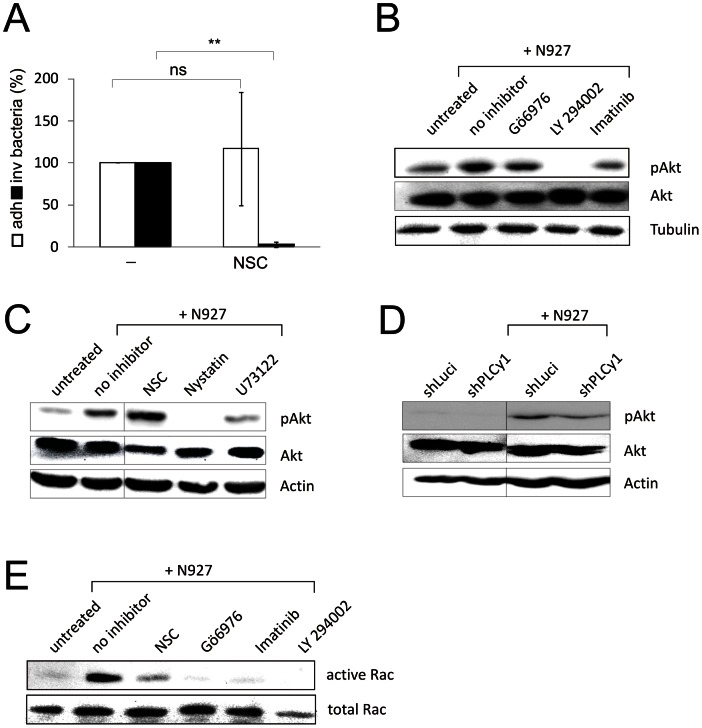
Signaling cascades leading to Akt phosphorylation and Rac1 activation.(A) Involvement of Rac1 in N927 (PorBIA, P−) invasion. Chang cells were pretreated for 1 h with the Rac1 inhibitor NSC23766 and subsequently infected with N927 (MOI 10; 30 min). Adherence (white bars) and invasion (black bars) were quantified by gentamicin protection assay. Shown are the mean values ± SD of three independent experiments performed in duplicates. The number of adherent (adh.) and intracellular (inv.) bacteria recovered from untreated control cells was set to 100%. p<0.01: **. (B,C) Chang cells were pretreated with kinase inhibitors (B) or inhibitors for other signaling factors (C) for 1 h, infected with N927 (PorBIA, P−) at MOI 50 for 30 min. Whole cell lysates were separated by SDS-PAGE and transferred to PVDF membranes. Blots were probed with antibodies against pAKT, as a readout for PI3K activity, AKT and either β-tubulin or actin as loading control. Inhibitors: Gö6976 for PKD1, LY294002 for PI3K, Imatinib for Abl1, NSC for Rac1, Nystatin for membrane rafts, U73122 for PLCy1. (D) PI3K is localized downstream of PLCγ1. Control cells (shLuci) as well as shPLCγ1 cells were infected with N927 (MOI 50; 30 min) and PI3K activity was assessed by detection of Akt phosphorylation as described in (B). (E) A novel signaling cascade leading to Rac activation after infection with N927. Chang cells were pretreated with the individual inhibitors for 1 h and infected with N927 at MOI 50 for 30 min. Active Rac1 was precipitated from cell lysates as described in Experimental Procedures. Western Blots were developed with an anti-Rac antibody.